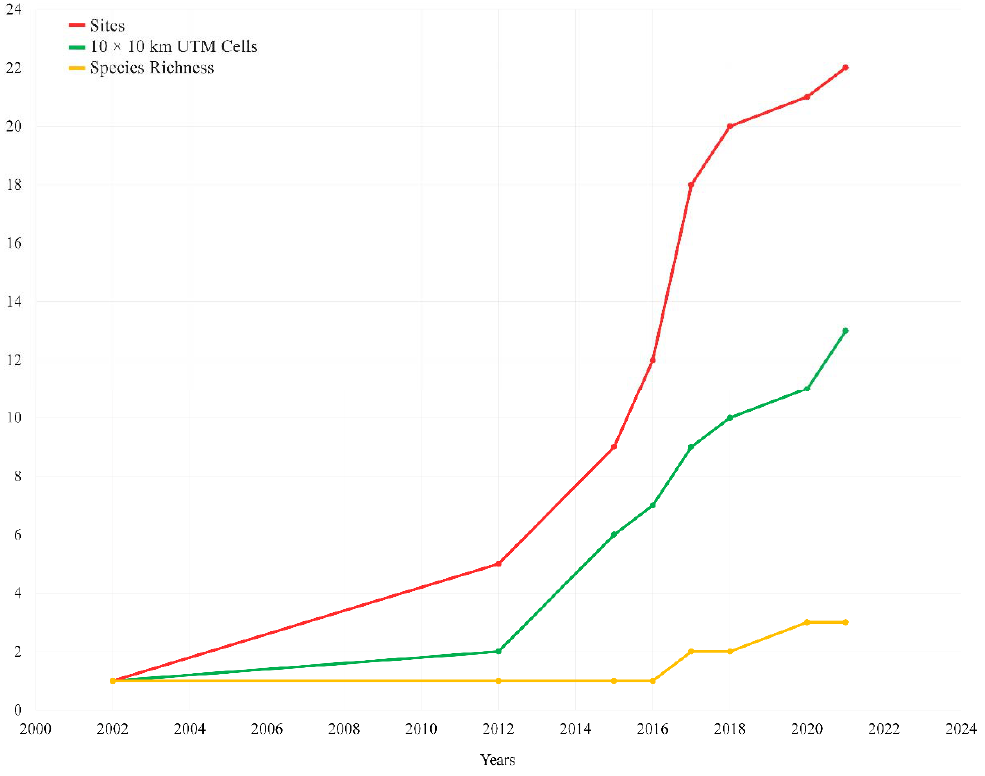
Figure 3. Cumulative curves of decapod NIS occurring in Sicily, from the first reported record in 2002 to today, based on “Sites” ( red line), “10 × 10 km UTM cells” ( green line) and “species richness” ( yellow line) data (see also Table 1).